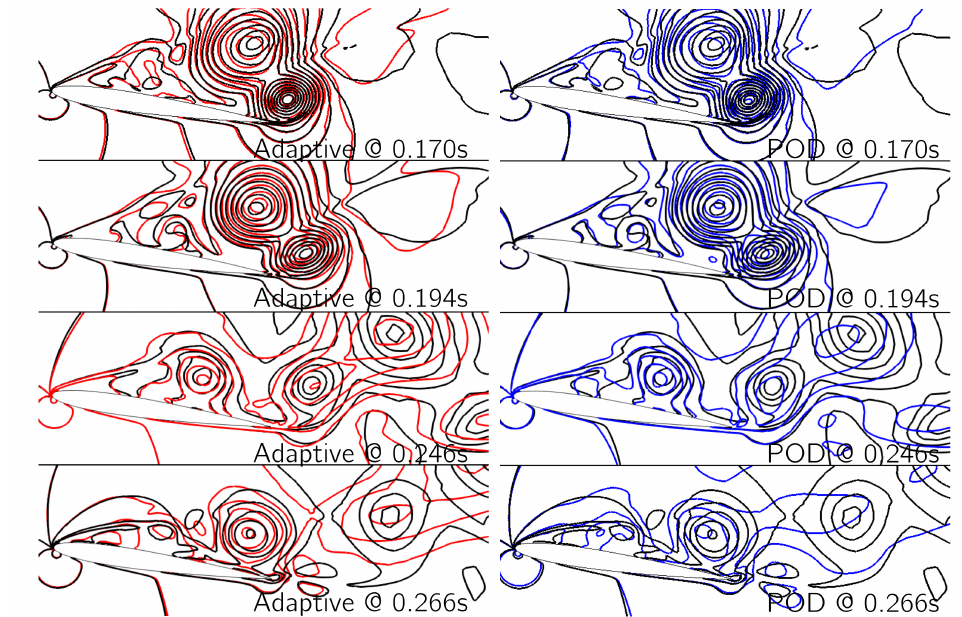
Figure 5. Comparison of the volume solution in terms of ρ . Coloured lines show the ROM reconstruction, while the black lines show the reference CFD solution. The left column shows the adaptive reconstruction, and the right column shows the pure POD reconstruction, both computed retaining 10 modes.